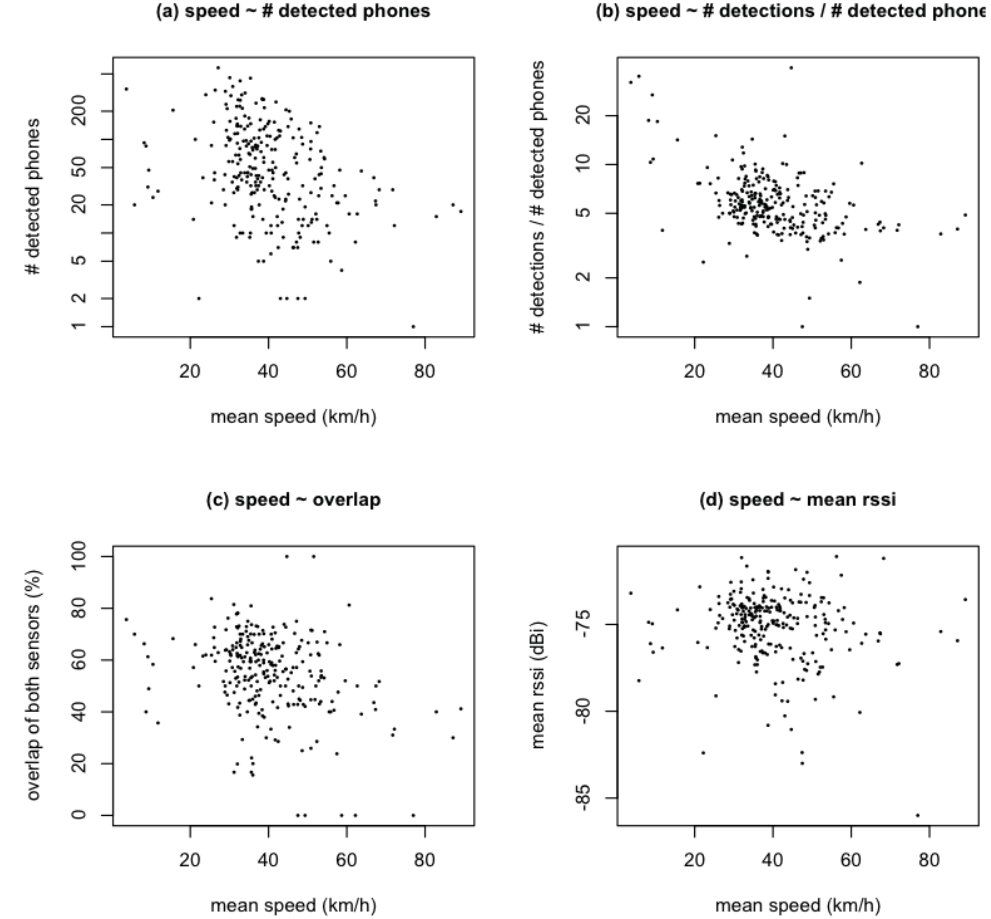
Figure 5. Real-life influence of mobile platform speed on four trajectory segment characteristics: ( a ) number of detected phones ( log scale ), ( b ) number of detections/number of detected phones ( log scale ), ( c ) sensor overlap, ( d ) mean